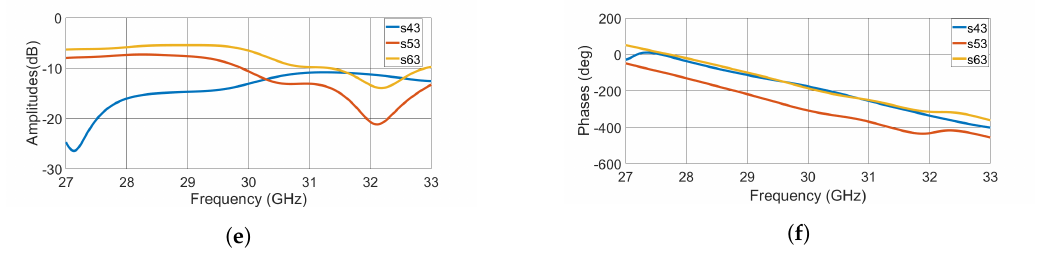
Figure 21. Ordinary Rotman lens with 4 dummy ports simulation results: ( a , c , e ) amplitudes | S ij | for the i = 1–3 outputs when the input ports j = 1,2,3 are excited; and ( b , d , f ) group delay for the i = 1–3 outputs when input ports j = 1,2,3 are excited.